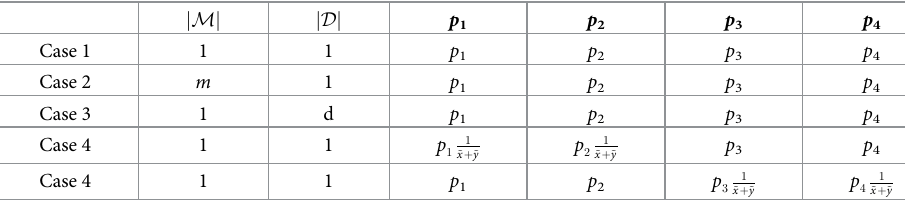
Table 1. Cardinality of neighbour sets and probabilities of changing opinion for each